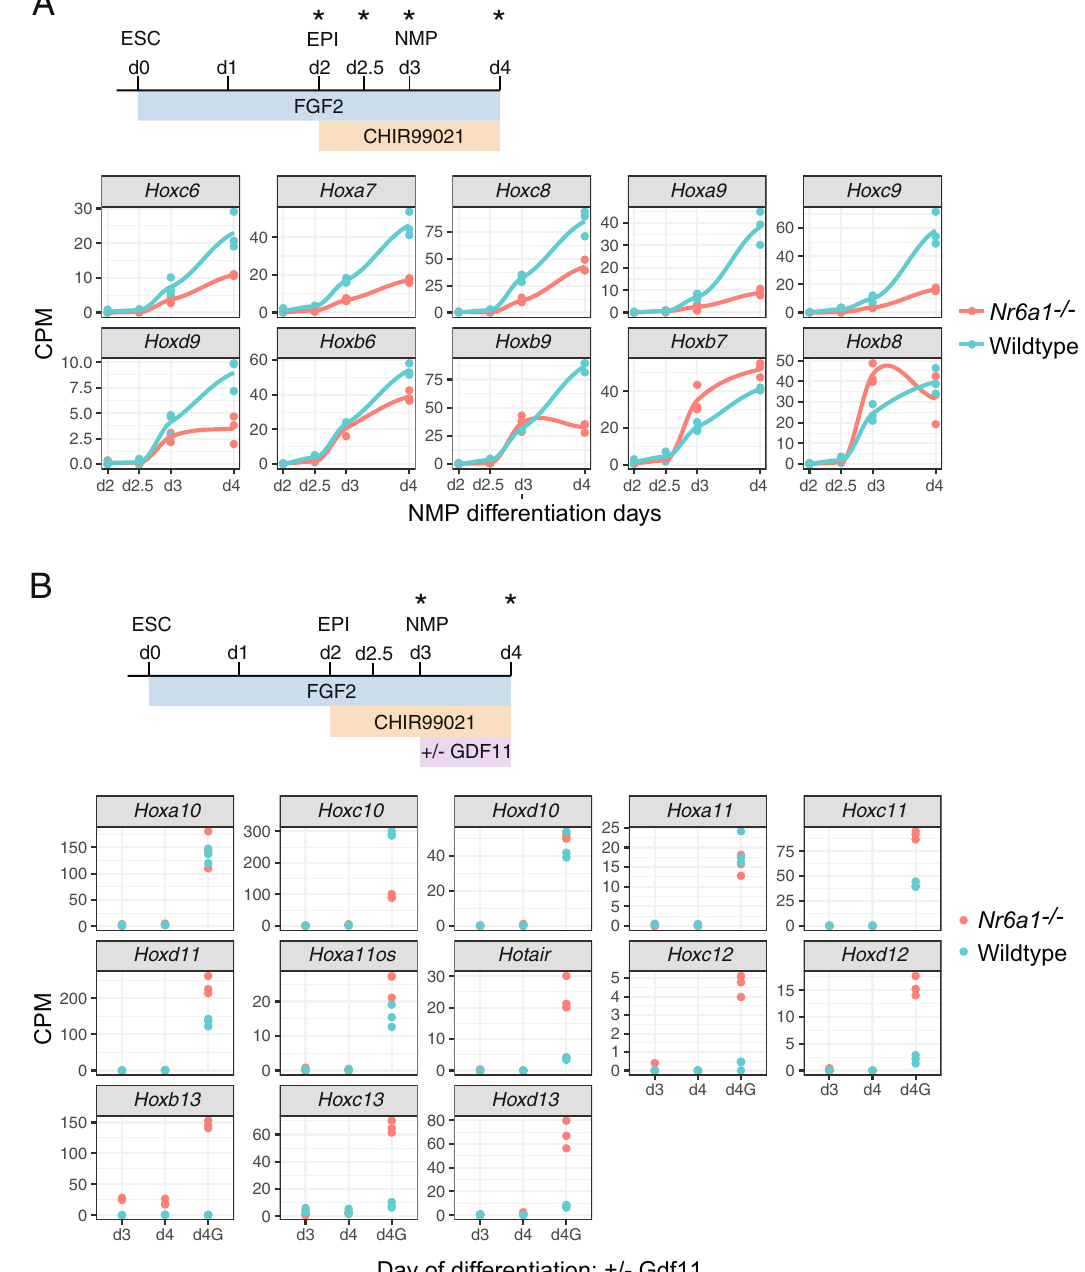
Fig. 7 | Nr6a1 and Gdf11 signalling cooperate in the control of Hox cluster transitions. A , B Differential Hox expression kinetics observed during in vitro differentiation of Nr6a1 and wildtype ESCs. Source data are provided as a Source Data fi le. A RNAseqanalysisoftrunk Hox geneexpression( Hox6 - 9 )in Nr6a1 − / − (red) and wildtype (blue) cells. In vitro differentiation protocol schematised, analysis timepointsmarkedwithasteriskanddatarepresentedascountspermillion(CPM).